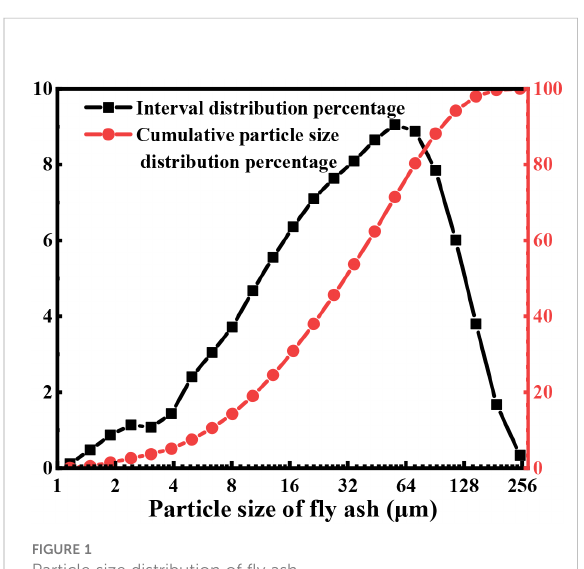
FIGURE 1 Particle size distribution of fl y